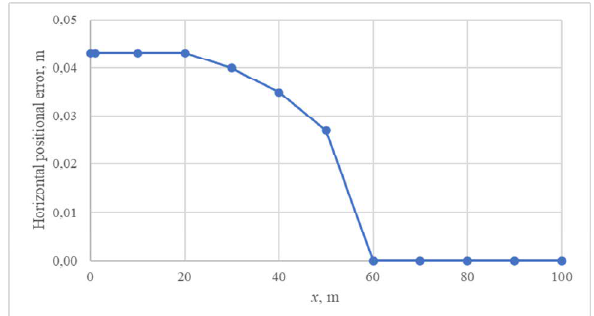
Figure 11 . The second example of the dependence between a horizontal positional error on a road sign and x value when there is vegetation among many pole-like infrastructures.